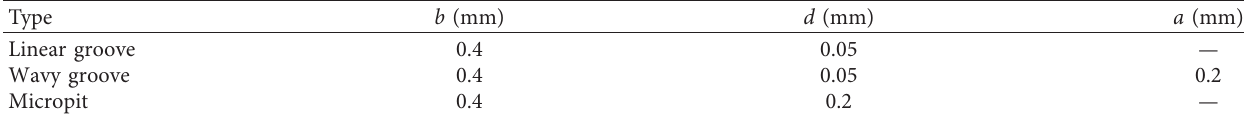
Table 2: Parameter of textured size.